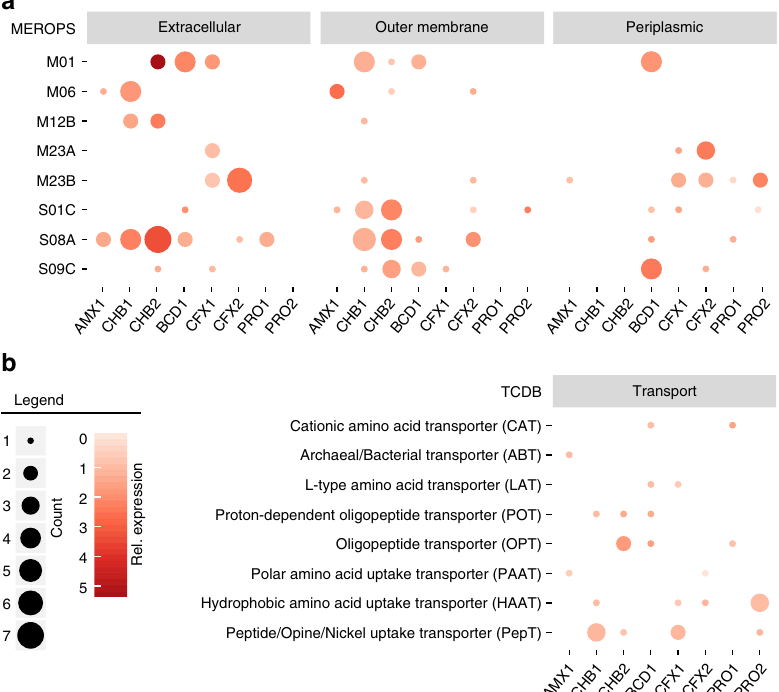
Figure 5 | Predicted peptidases and amino acid transporters recovered from the MAGs. ( a ) Number (bubble diameter) and relative gene expression (bubble colour intensity) of selected peptidases possibly involved in EPS matrix protein degradation. Peptidases were annotated against the MEROPS database 66 . The subcellular location (extracellular, outer membrane or peroplasm) of each peptidase was predicted using the subcellular localization predictor (CELLO) 69 . A summary of all predicted peptidases can be found in Supplementary Data 5. ( b ) Number (bubble diameter) and relative gene expression (bubble colour intensity) of amino acid and peptide transporters predicted across the recovered genomes. Transporters were annotated against the transporter classification database (TCDB) 70 and can be found in Supplementary Data